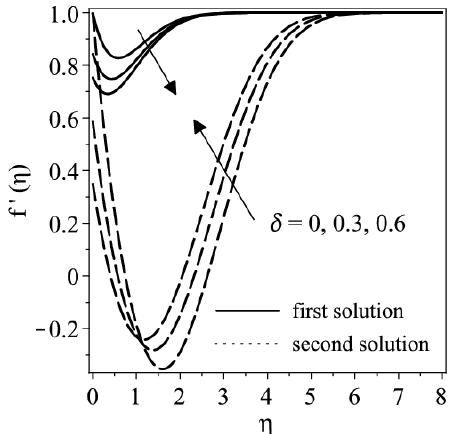
Figure 3. Effect of the slip parameter δ on the velocity profiles f ′ ( η ) when ε = 1, Pr = 1 and λ = − 2 (opposing flow).